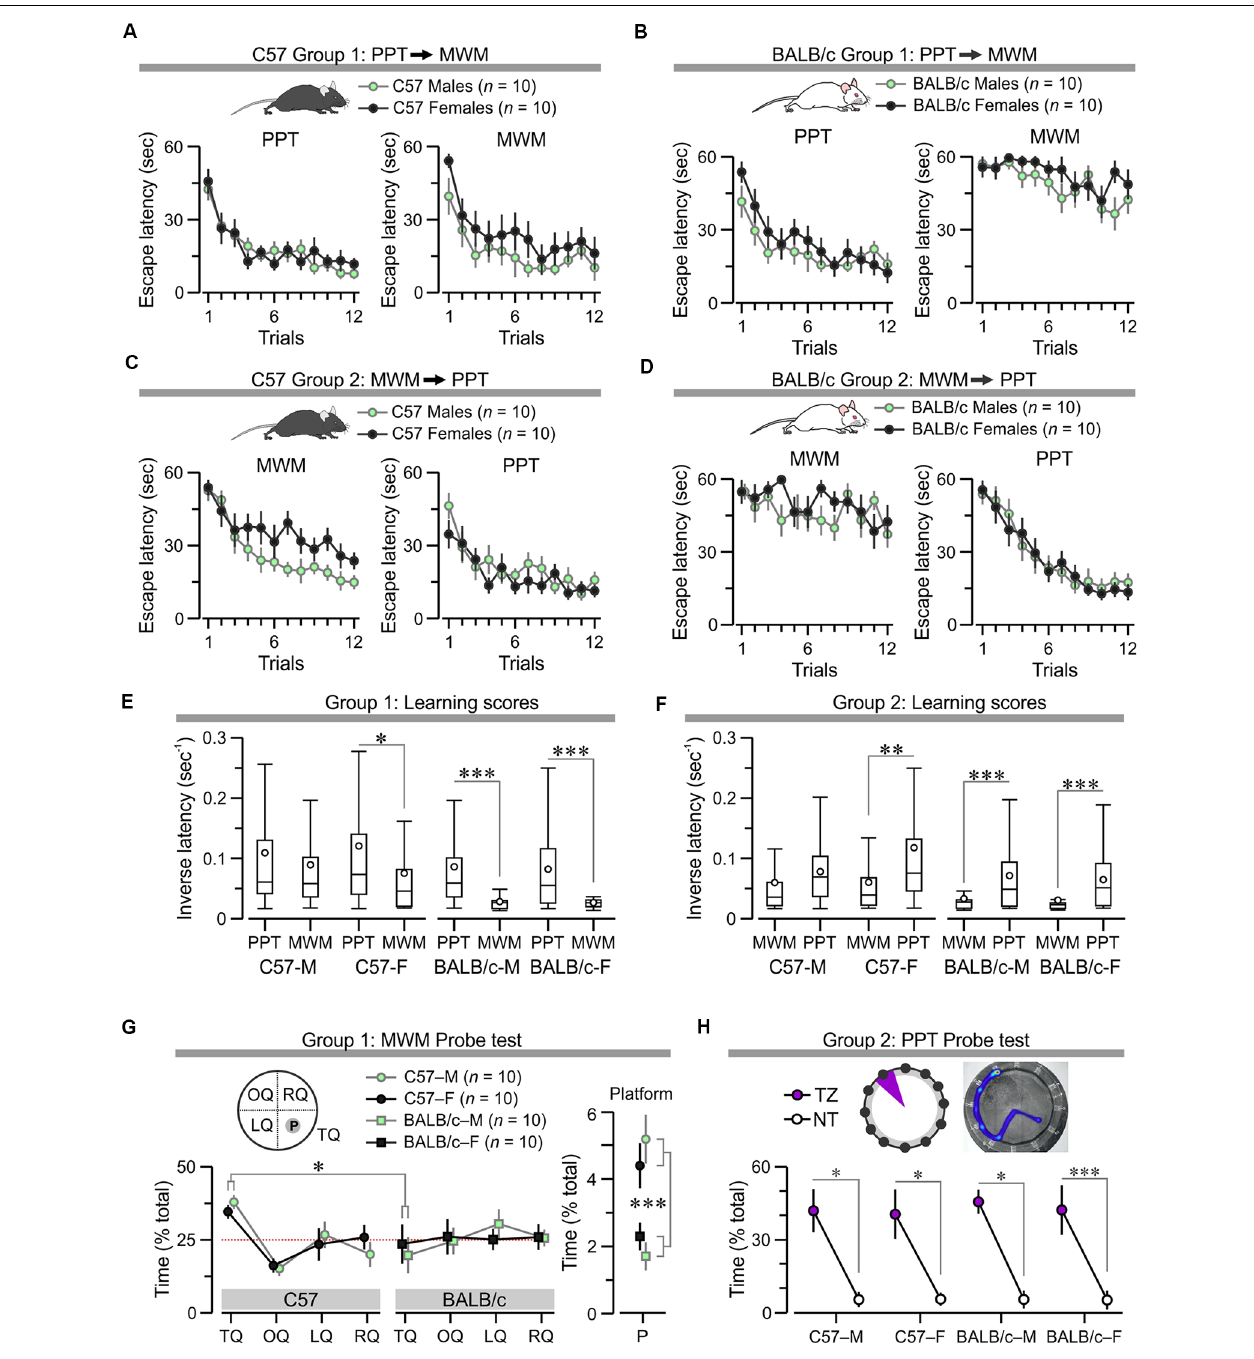
FIGURE 8 | Comparison of the PPT and MWM in C57 and BALB/c mice. (A–D) Plots of escape latency (mean ± SEM) across trials, arranged by group/strain, showing that C57 mice acquire the PPT and the MWM normally and independently of testing order (A,C) , while BALB/c mice acquire the PPT normally but are impaired in the MWM (B,D) . (E) Boxplot of learning scores (i.e., inversed latency calculated for all trials) for subjects in Group 1 shows that only C57 males (C57-M) learn the PPT and the subsequent MWM with equal ease ( T ( 238 ) = 1.35, P = 0.18, t -test), whereas the other groups show poorer acquisition of the MWM (C57 females, C57-F, T ( 238 ) = 2.79, ∗ P = 0.004; BALB/c males, BALB/c-M, T ( 238 ) = 7.17, ∗∗∗ P = 9.48 × 10 − 12 ; BALB/c females, BALB/c-F, T ( 238 ) = 8.41, ∗∗∗ P = 3.74 × 10 − 15 , t -test). (F) Boxplot of learning scores for subjects in Group 2 shows that C57 males learn the MWM and the PPT equally (C57-M, T ( 238 ) = 2.34, P = 0.02, t -test), whereas the other cohorts learn the MWM more poorly than the PPT (C57-F, T ( 238 ) = 3.93, ∗∗ P = 0.0001; BALB/c-M, T ( 238 ) = 5.72, ∗∗∗ P = 3.26 × 10 − 8 ; BALB/c-F, T ( ∗∗∗ P = 4.1 × 10 − 10 , t -test). (G) Subjects in Group 1 were subjected to a probe test following the MWM. The left plot 238 ) = 6.53, shows preferential search of the target quadrant for C57 mice but not BALB/c mice ( T ( 38 ) = 3.13, ∗ P = 0.003, t -test). The right plot shows that C57 mice spend ( Continued )